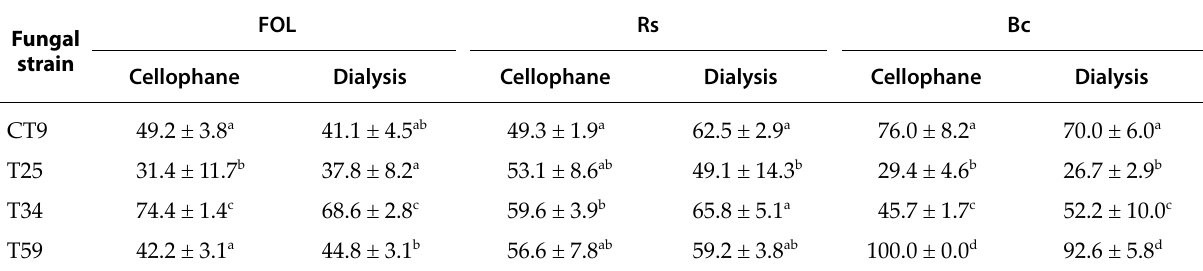
Values are means of three replicates with the corresponding standard deviation. For each column, values with different superscript let - ters are significantly different according to Tukey’s test ( P <